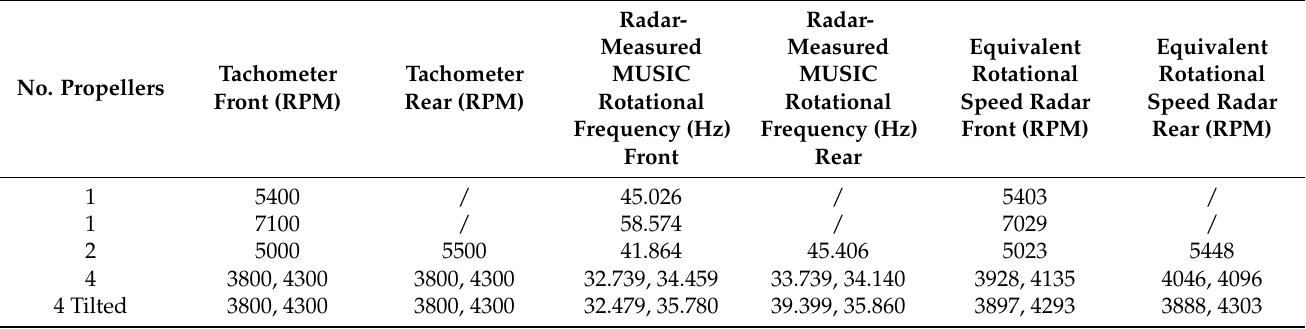
Table A6. Results obtained with a MUSIC signal subspace of one thousand and